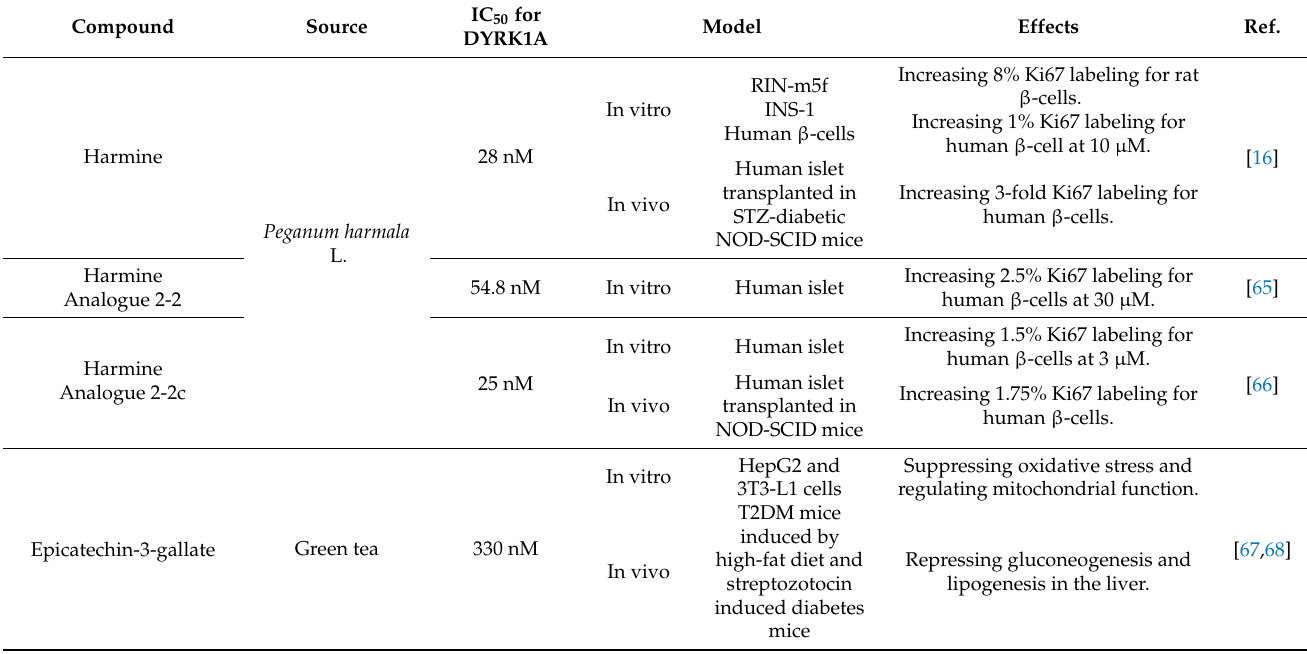
Table 1. Regeneration of pancreatic β -cells for diabetes therapeutics by natural DYRK1A